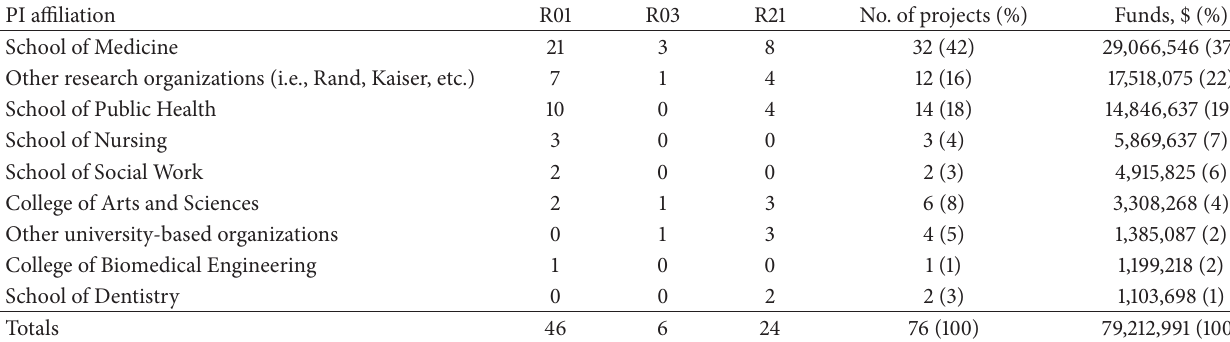
Table 2: Projects by PI affiliation, mechanism, and total